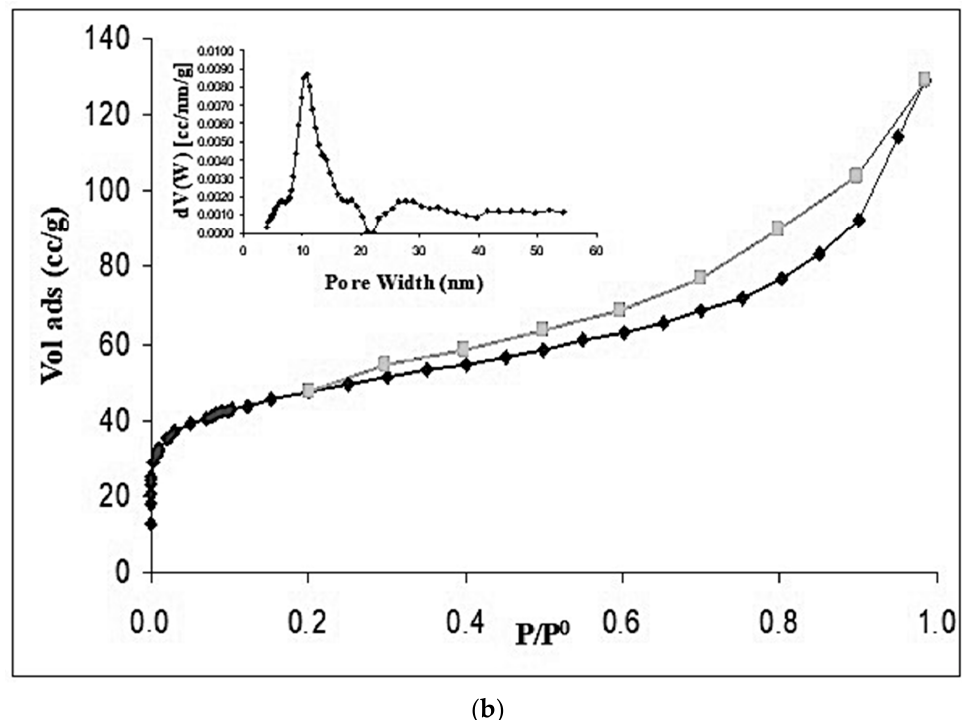
Figure 9. N 2 gas adsorption-desorption isotherms of samples and pore size distribution (PSD) calculated with quenched solid density functional theory (QSDFT) kernel: ( a ) Gr ( b ) GO ( c ) simulation of Gr with nonlocal density functional theory (NLDFT) and